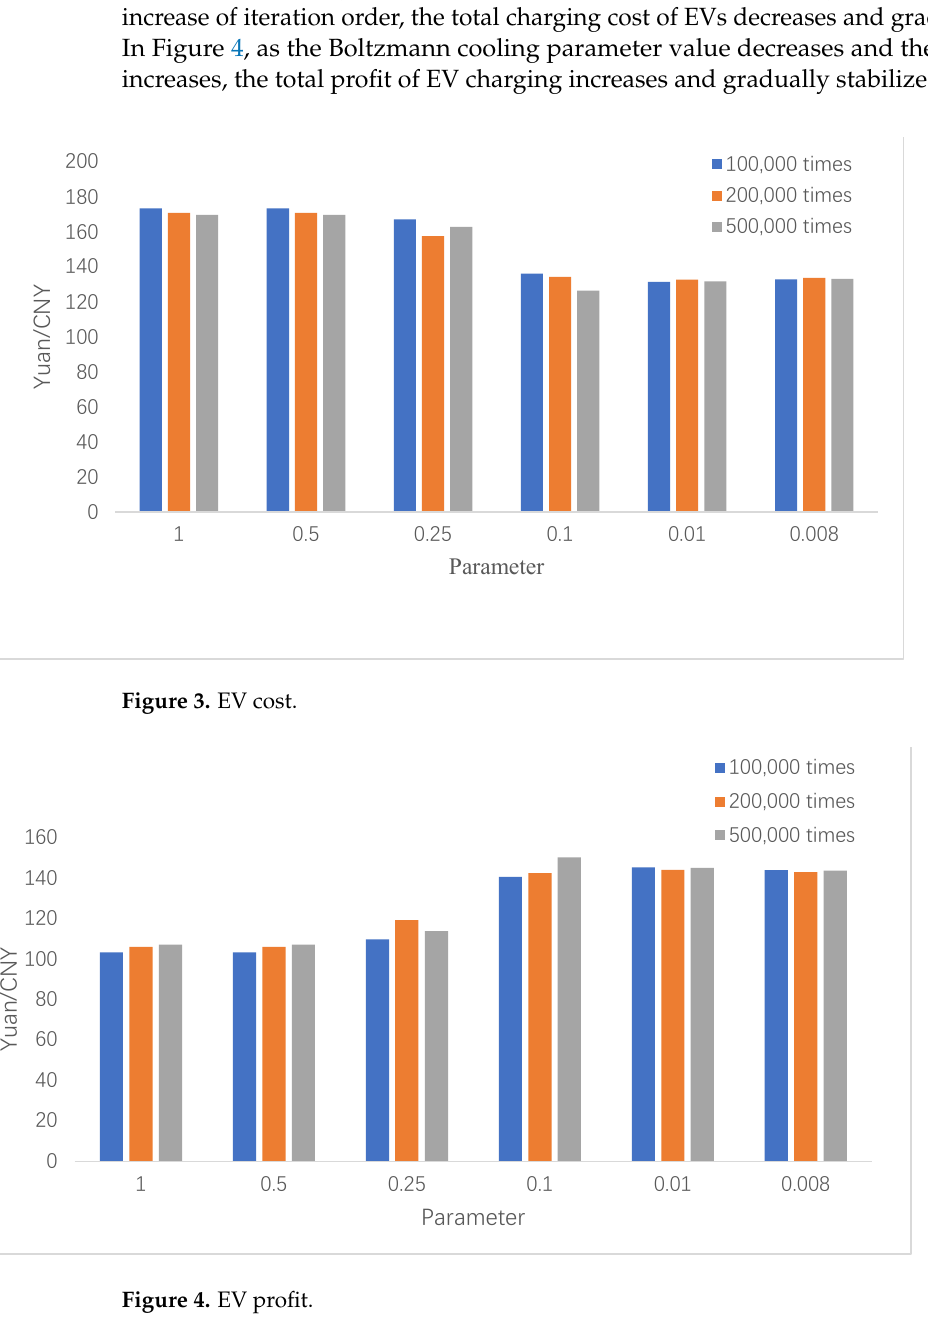
Figure 5. Costs and profits with Boltzmann cooling parameter value of 0.1.